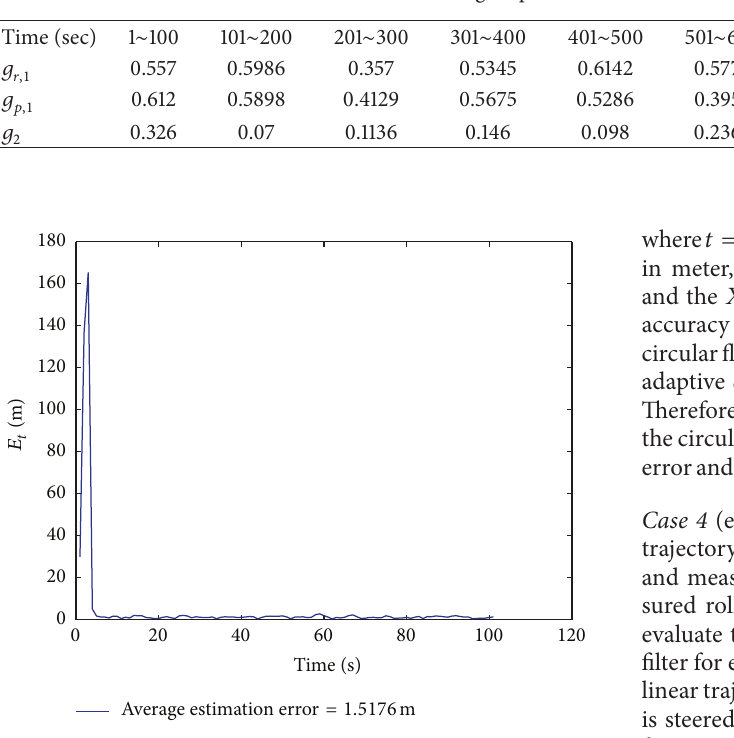
Figure 9: Estimation error for linear target trajectory without beam pointing